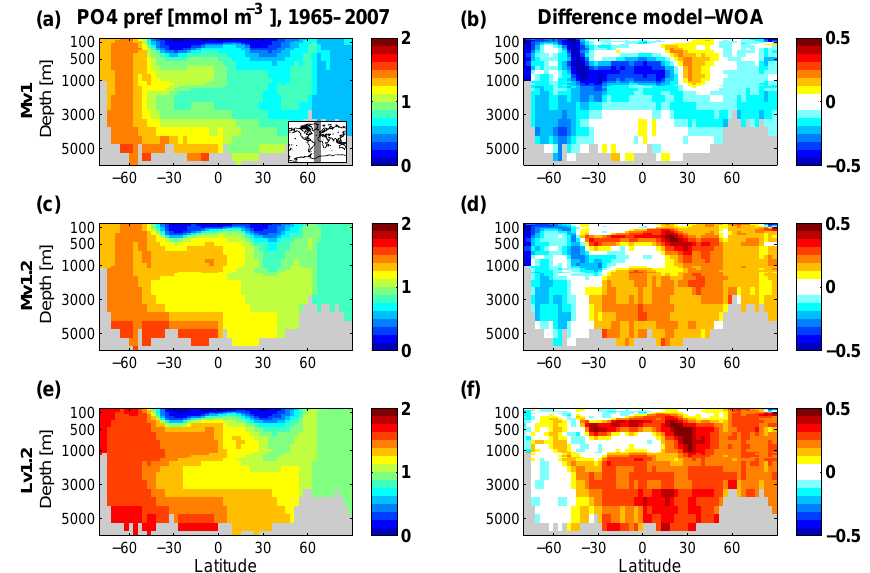
Figure 12. As Fig. 11 but for preformed phosphate (mmolm − 3 ). The remineralised fraction of phosphate is approximated by apparent oxygen utilisation (AOU) divided by the stoichiometric oxygen to phosphorus ratio R O